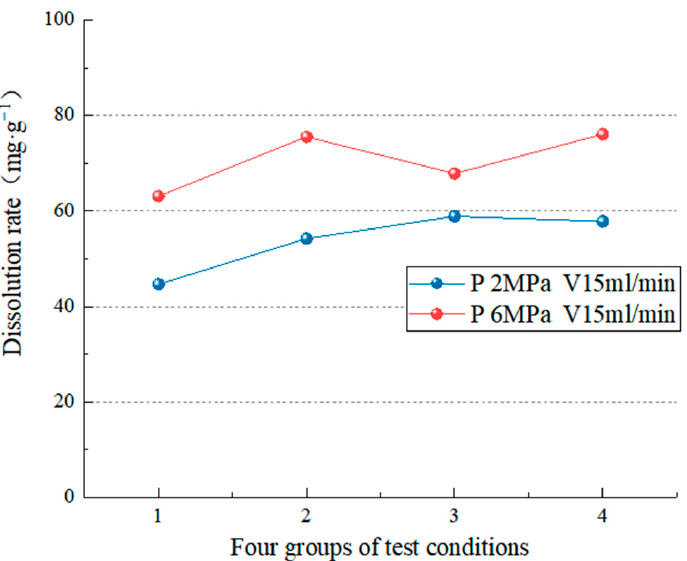
Figure 9. Comparison of the dissolution rate at a water flow velocity of 15 mL/min.